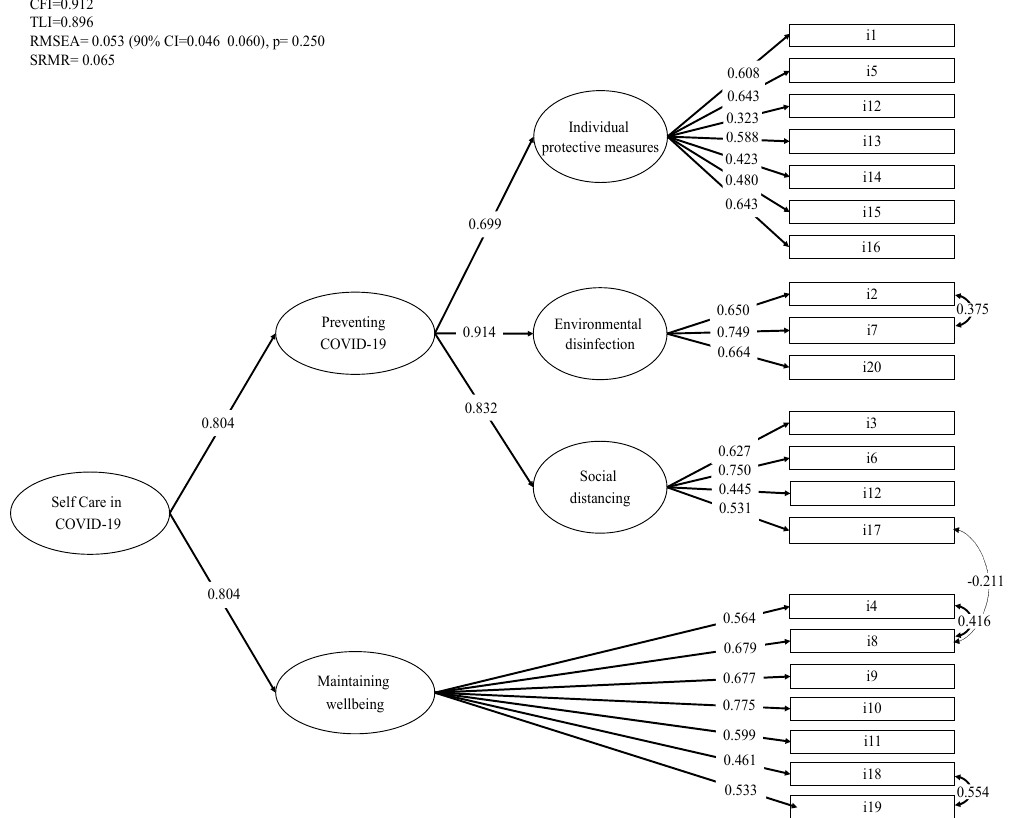
Figure 2. Confirmatory factor analysis of the SCOVID scale. Note : The results come from Mplus and are completely standardized solutions. All coefficients were statistically significant ( p < 0.05). The numbers near the one-headed arrows are factor loading coe ffi cients; the numbers near the two-headed arrows are correlation coe ffi